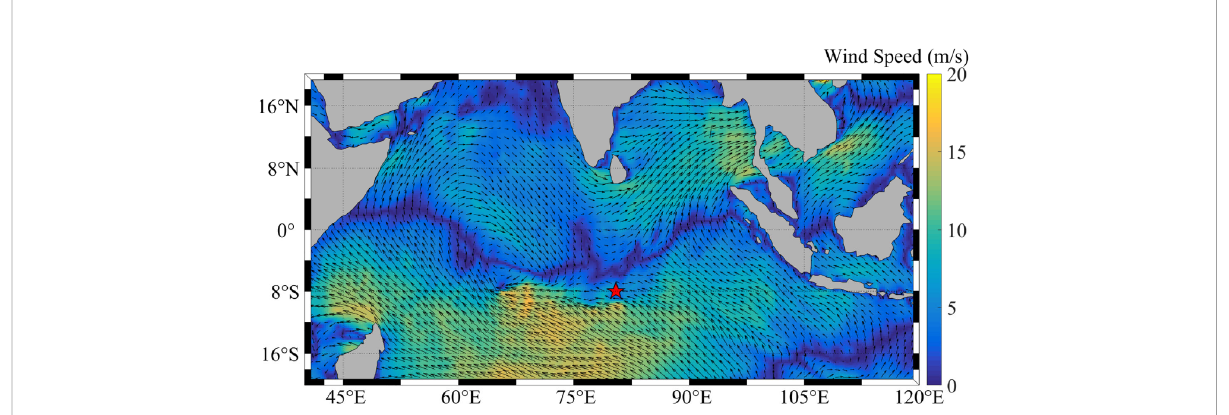
FIGURE 1 Map of the tropical Indian Ocean. The red star shows the fi xed site where the dataset used in this study was collected. The contour and vector indicate the wind fi eld at 10 m height above the sea surface on 30 September 2011 (i.e., the fi rst day of the fi eld campaign), which is from the ECMWF ERA5 reanalysis wind data at